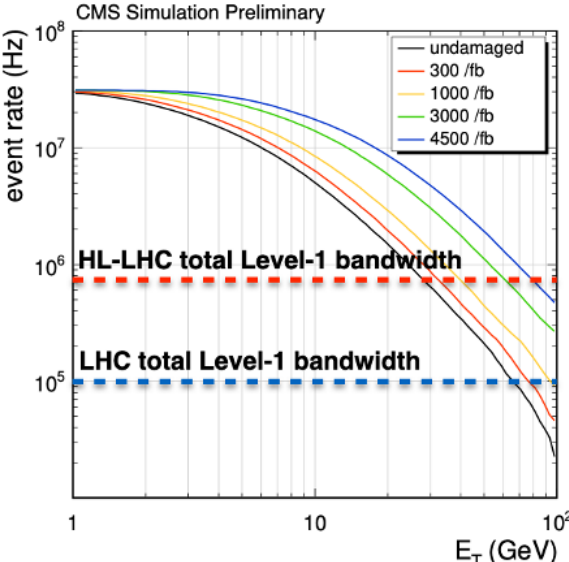
Figure 8. Expected rate of events for the HL-LHC in the CMS ECAL with 200 pileup, showing the energy deposits above specific thresholds after an integrated luminosity of 300, 1000, 3000 and 4500 fb − 1 without any spike suppression applied. The L1 bandwidth for the current LHC and the HL-LHC are also shown on this plot [6].